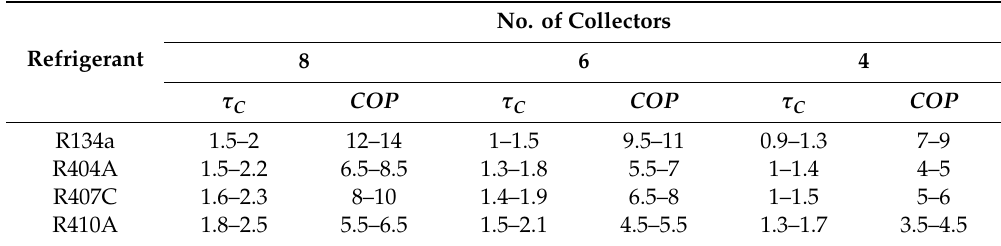
Table 5. Tendency ranges of the relative e ffi ciencies of the DXSAHP